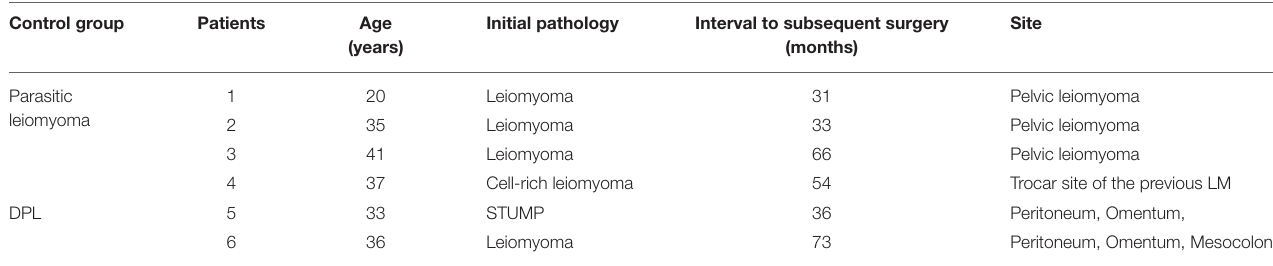
TABLE 6 | Power morcellation-related reoperation of benign pathologies in the control group. Control